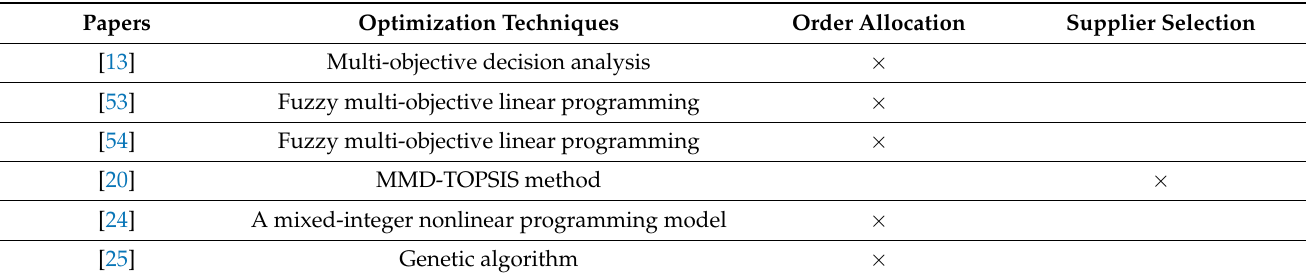
Table 1. Optimization Techniques Review of